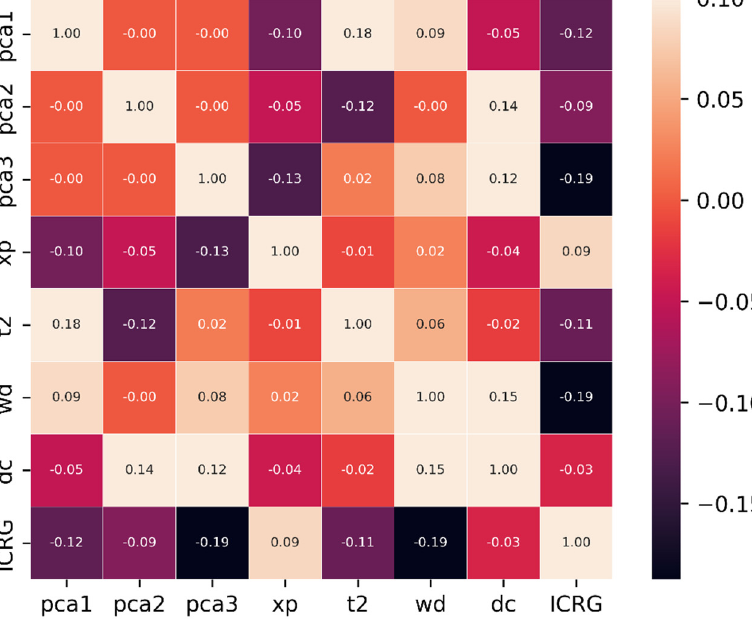
Figure 3. Correlation coefficient heatmap after principal component analysis.